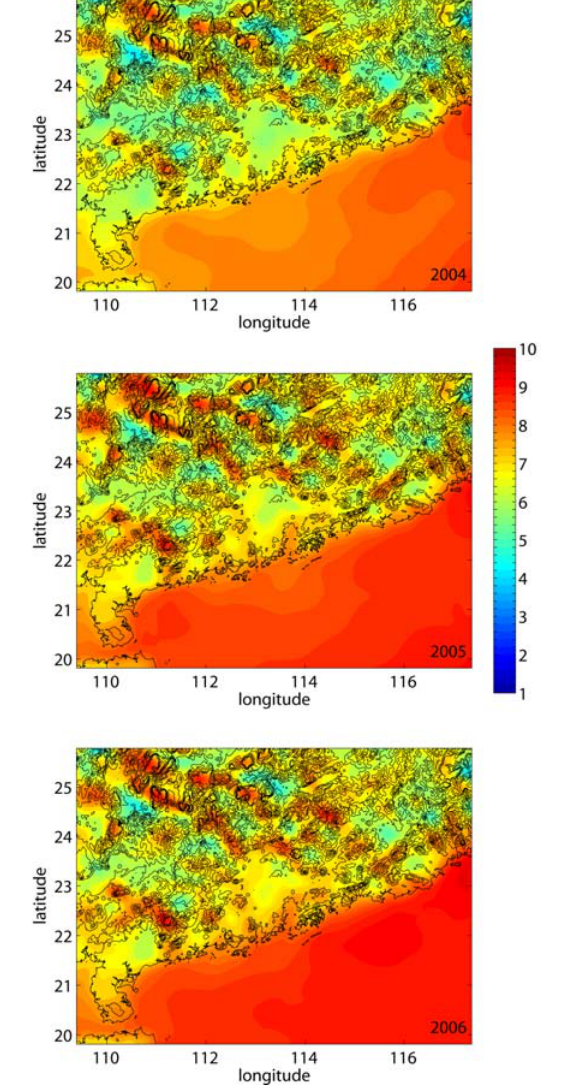
Figure 10. Scale parameter c (m/s) at 60 m above ground over GD in (a) 2004, (b) 2005 and (c)